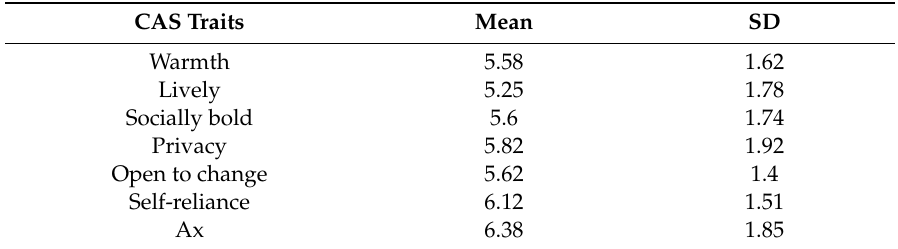
Table 2. Personality factors for empathy and